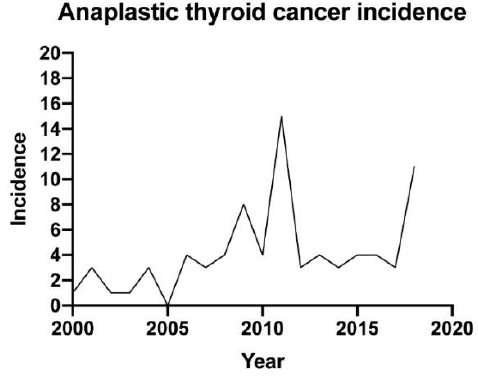
Figure 1. Anaplastic thyroid cancer incidence. Table 1. Clinicopathological characteristics.